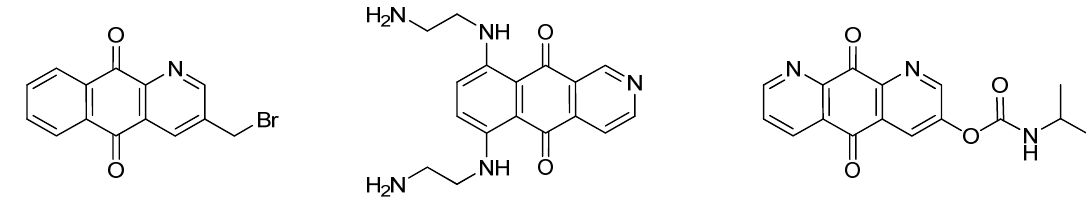
Figure 1. Examples of aza-anthraquinones with potent antitumor activity.